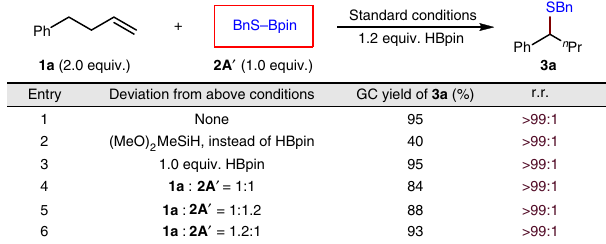
Fig. 7 Optimized reaction conditions using RS – Bpin as the thiolation reagent. 0.20 mmol Scale, average of two